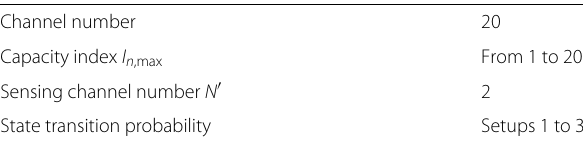
Table 1 Simulation setup